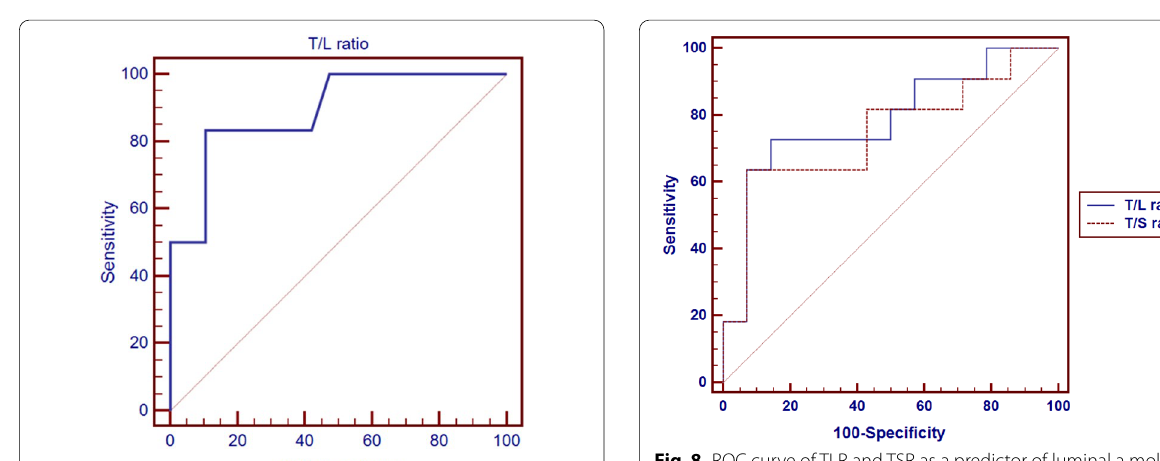
Fig. 8 ROC curve of TLR and TSR as a predictor of luminal a molecular subtype